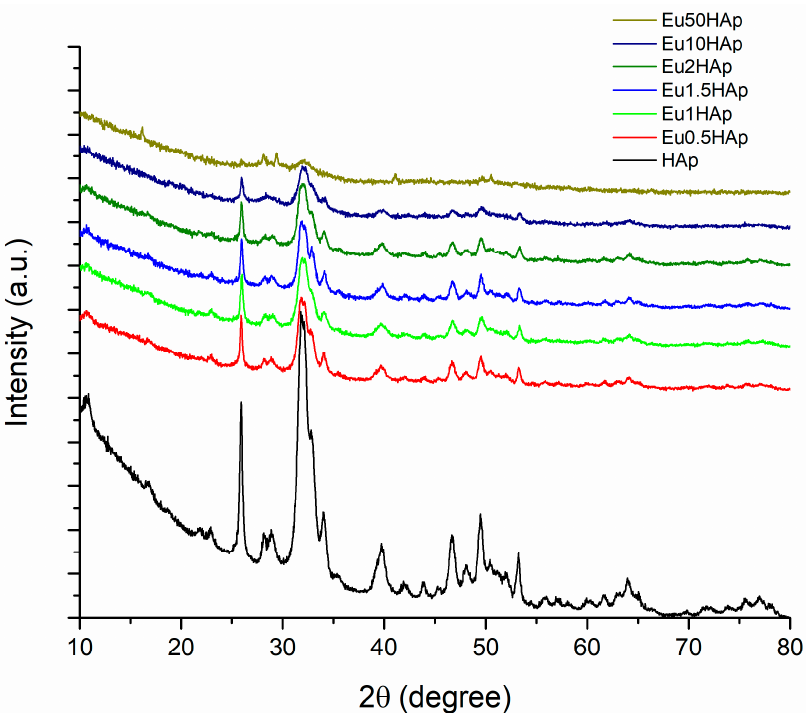
Figure 1. X -ray di ff raction patterns of hydroxylapatite (HAp) and Eu X HAp. Figure 1. X -ray diffraction patterns of hydroxylapatite (HAp) and Eu X HAp.